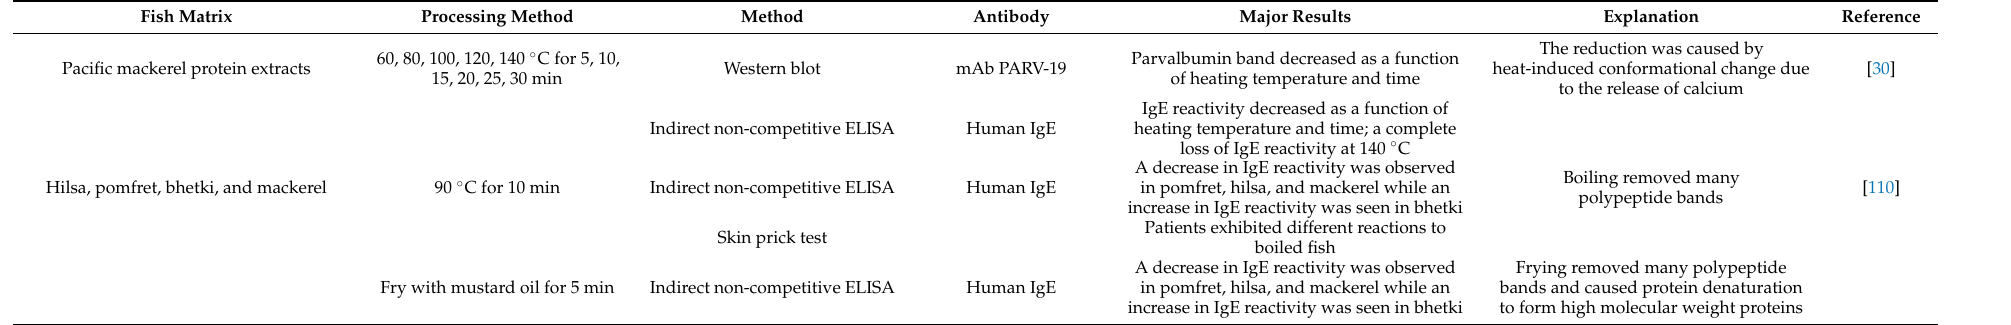
Table 5. Effect of processing on fish protein solubility, antigenicity, and